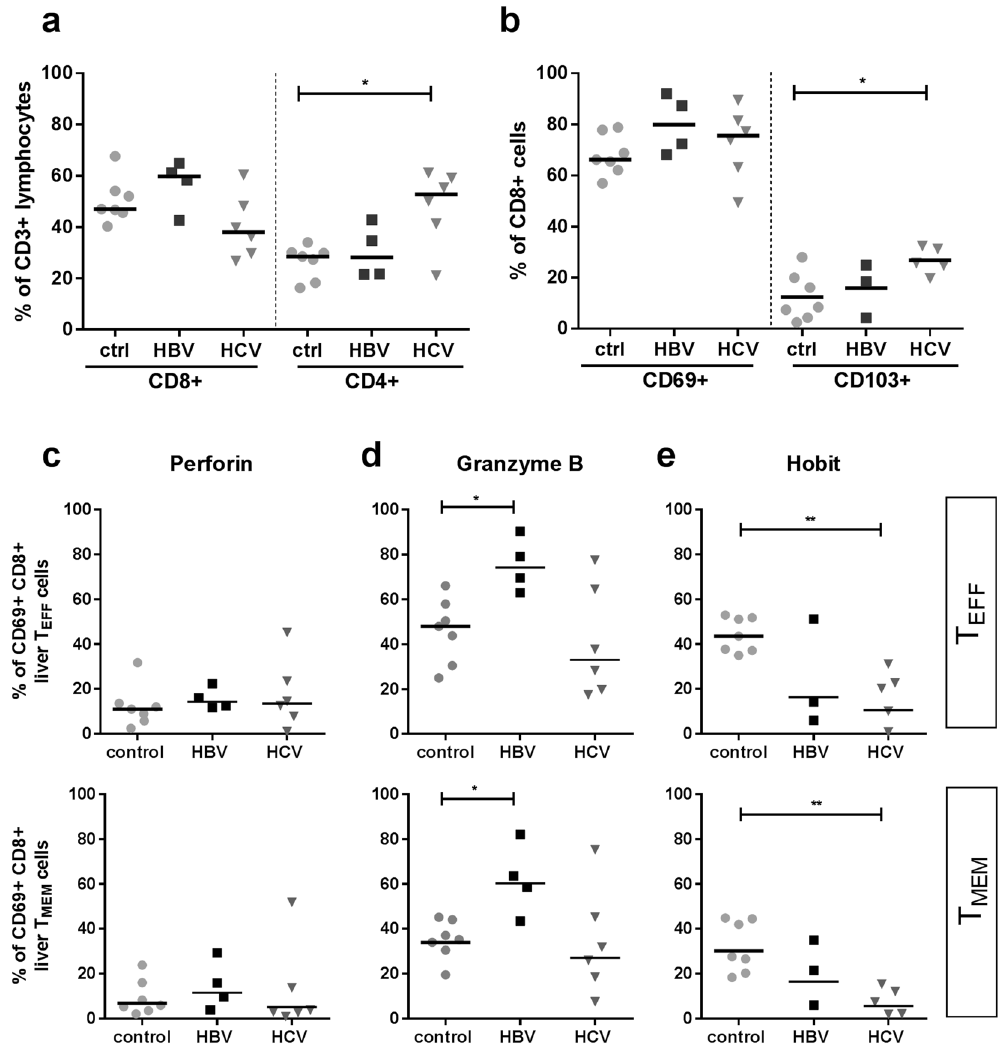
Figure 5. ( a ) Frequency of CD8 + and CD4 + T cells as a percentage of total CD3 + T lymphocytes in control (ctrl, n = 7), CHB infected (HBV, n = 3–4) and CHC infected (HCV, n = 5–6) livers (number of samples depending on sample availability). Bars indicate median. Statistical analyses; Mann-whitney test. ( b ) Frequency of CD69 + and CD103 + as a percentage of total CD8 + T lymphocytes in control, HBV and HCV livers. Bars indicate median. Statistical analyses; Mann-whitney test. Frequency of perforin + ( c ), granzyme B + ( d ) and Hobit + ( e ) CD8 + T cells as a percentage of intrahepatic CD69 + CD8 + T EFF (upper graphs) and T MEM (lower graphs). Bars indicate median. Statistical analyses; Mann-whitney test. * p < 0.05, ** p <